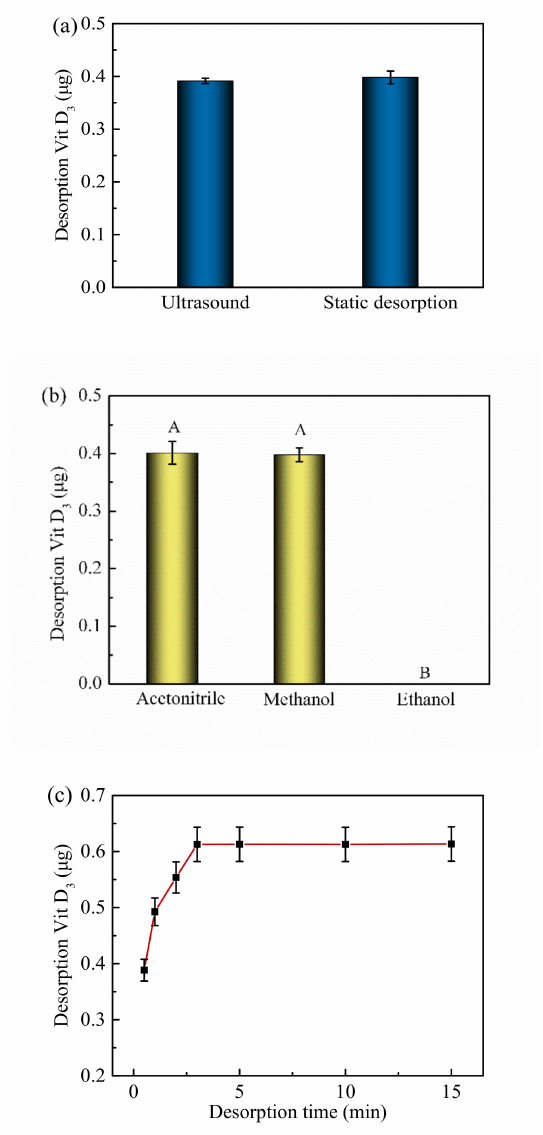
Figure 5. Effects of factors on VD 3 desorption from Fe 3 O 4 @PPy composites. ( a ) Desorption method, ( b ) desorption solvent, and ( c ) desorption time. Data are expressed as the mean ± standard deviation ( n = 3). The different capital letters (A,B) indicate a significant difference ( p <